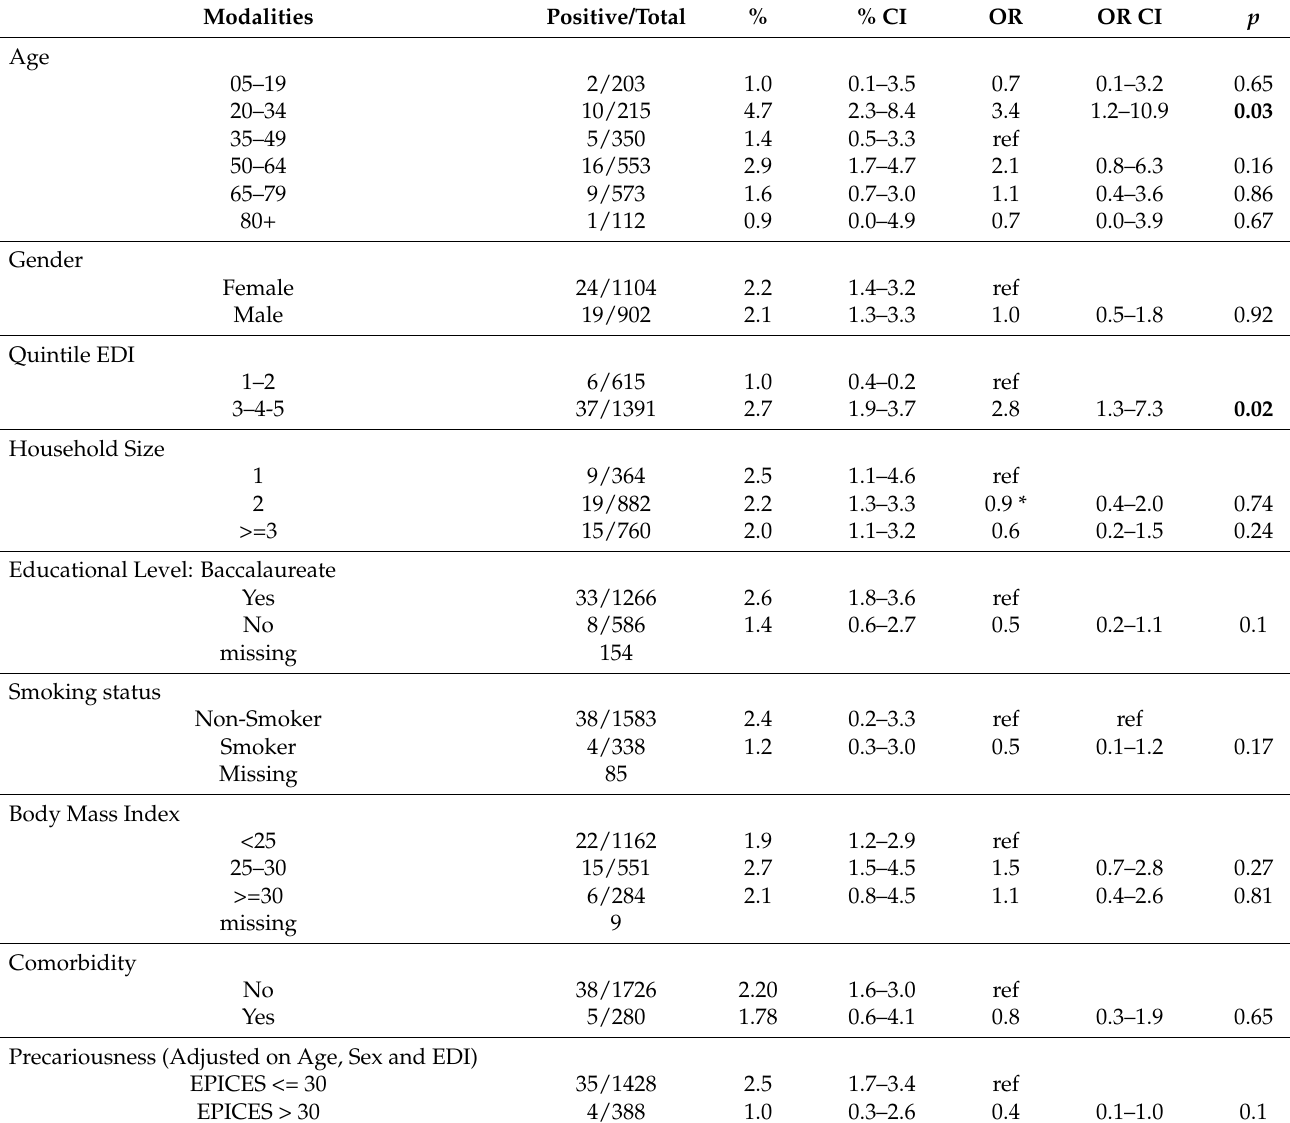
Table 2. Number of cases, seroprevalence for each risk factor modality. Data are 95% confidence intervals (CIs), odds ratios (ORs) and p values. (Bold indicate significance at 0.05